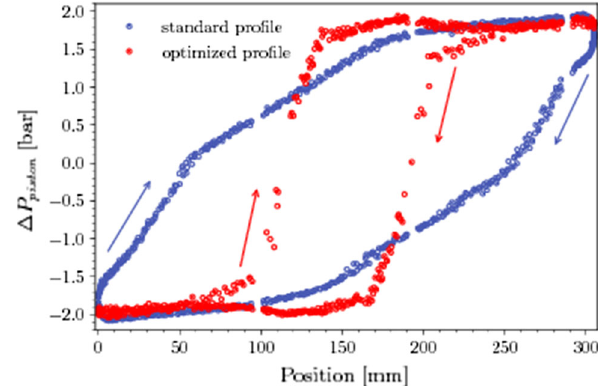
Fig. 14 Piston pressure Δ P piston vs the position of the external ring using xenon gas with a mean inlet pressure of ( 1 . 8 ± 0 . 1 ) bar. The optimized drive profile (red) allows to build up and hold a high piston pressure much faster and longer compared to the linear profile (blue). The arrows indicate the movement of the piston during a full stroke up and down